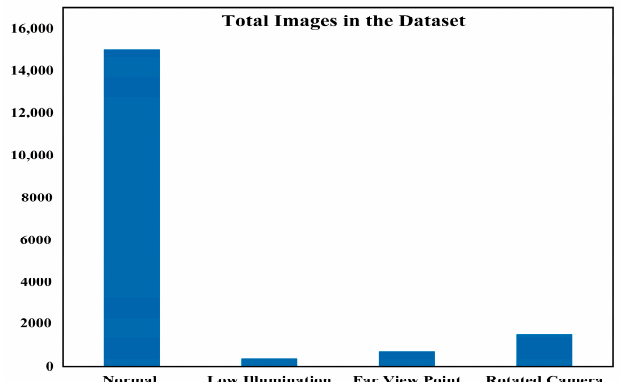
Figure 1. Captured apple images at varied conditions.